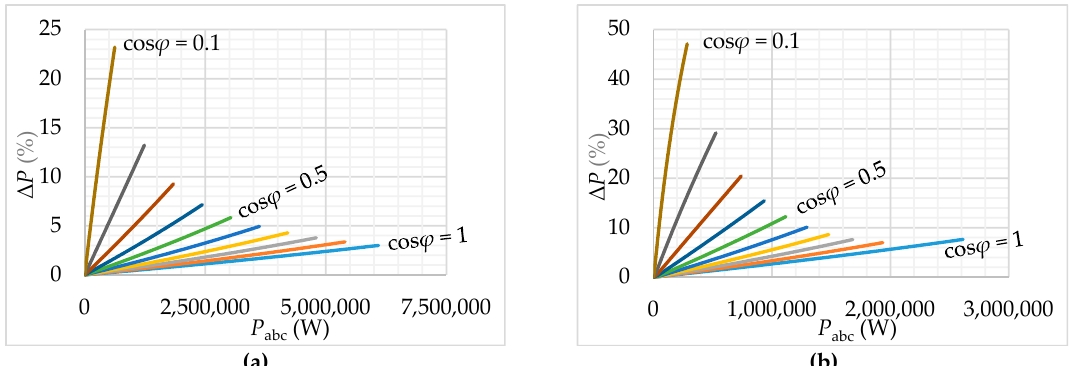
70/11: ( a ) the length of 5 km; ( b ) the length of 30 km. 70 / 11: ( a ) the length of 5 km; ( b ) the length of 30 km. Energies 2019 , 12 , x FOR PEER REVIEW